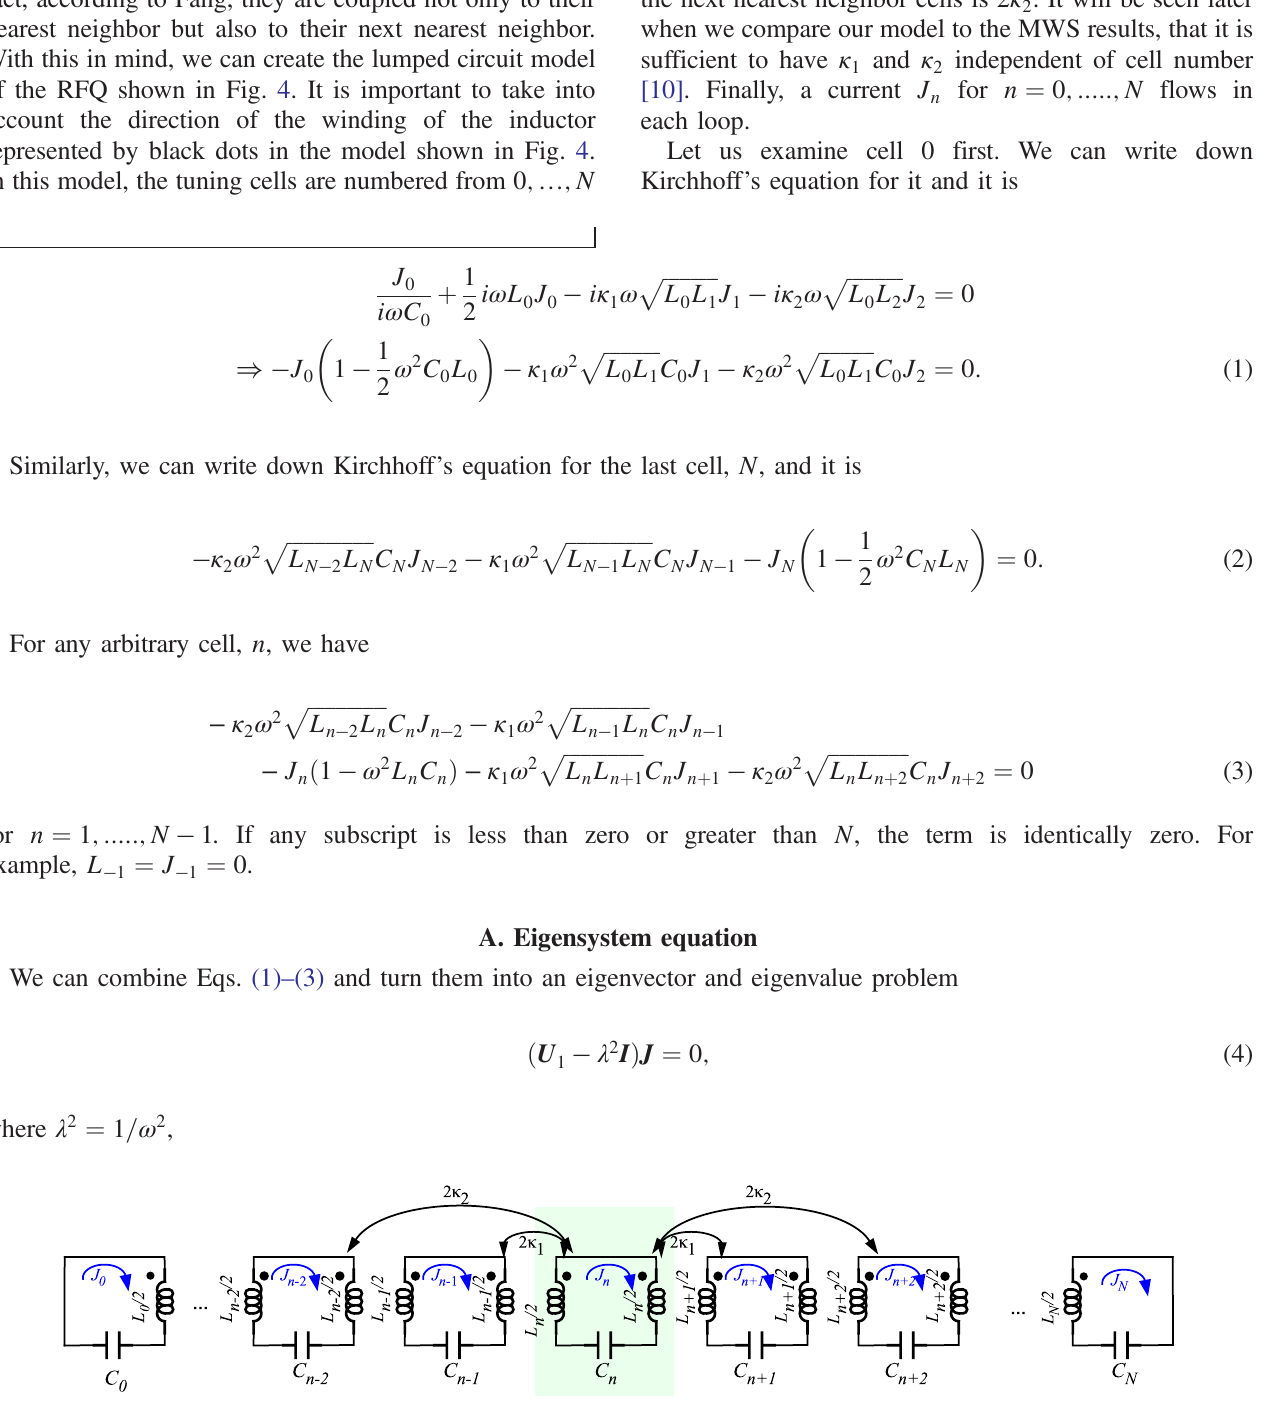
FIG. 4 (color online). The RFQ lumped circuit model. The highlighted n th cell shows how it is coupled to its first and second neighbor circuits. Each closed circuit represents a tuning cell. Notice the filled dot that is associated with each inductor. The location of the filled dot and the direction of the current determines the sign of the induced voltage that comes from coupling between cells. For an example, see